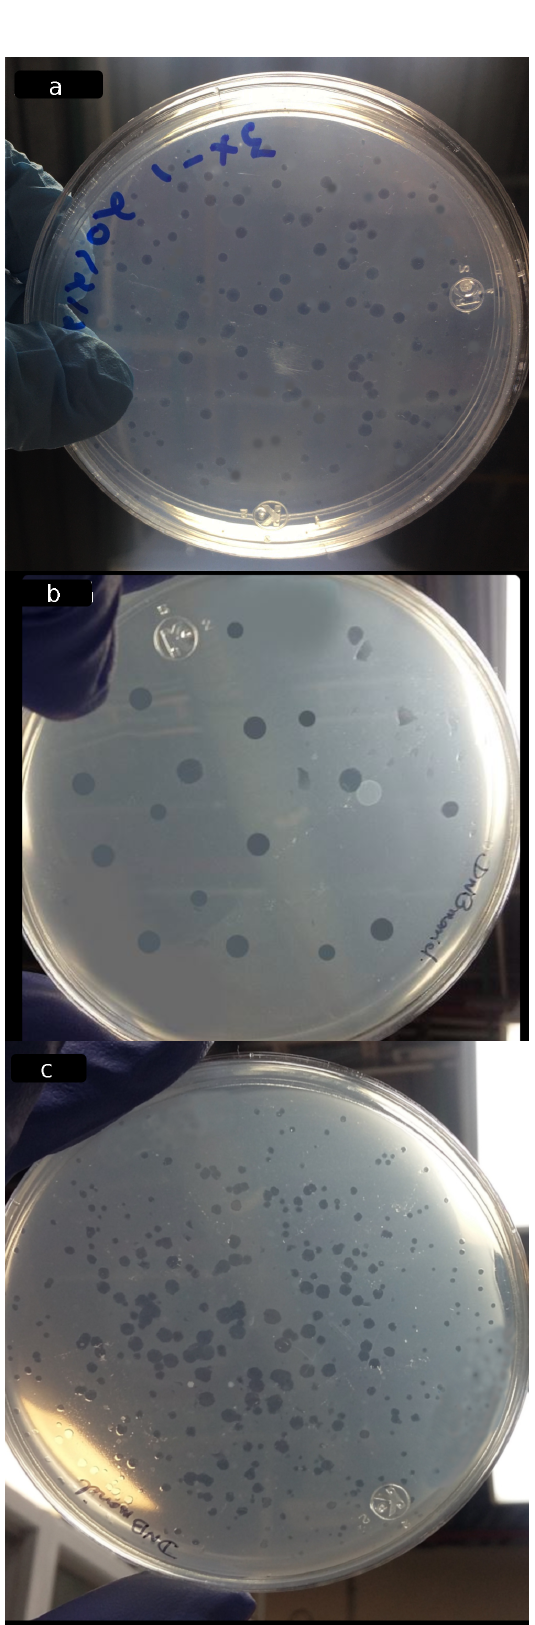
Figure 7. Comparison of lytic plaques developed by B. bacteriovorus HD100 on the lawn of Escherichia coli DH5 α prey cells. Inhibition zones are observed in StA-G ( a ), CA-G ( b ), and CA-S ( c )